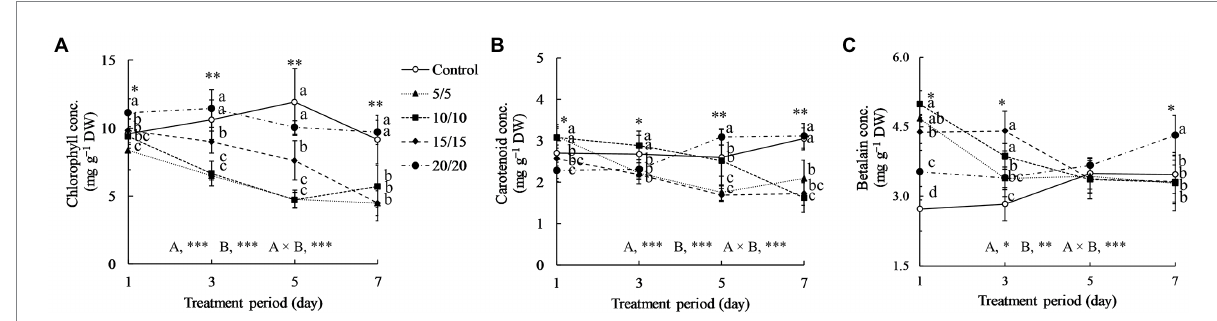
FIGURE 3 Total chlorophyll (A) , carotenoid (B) , and betalain (C) concentrations (conc.) in leaves of amaranth seedlings treated with different short-term RZTs for different periods (Experiment 1). Results of two-way analysis of variance for RZT (A), period (B), and their interaction (A × B) are shown. The asterisks indicate the significance levels ( * p < 0.05, ** p < 0.01, and *** p < 0.001). Vertical bars indicate the standard error ( n = 4). Means were compared using Tukey’s HSD at a significance level at * p < 0.05 and ** p < 0.01. Betalain concentrations are expressed as β -cyanin and β -xanthin equivalents. DW, dry weight.